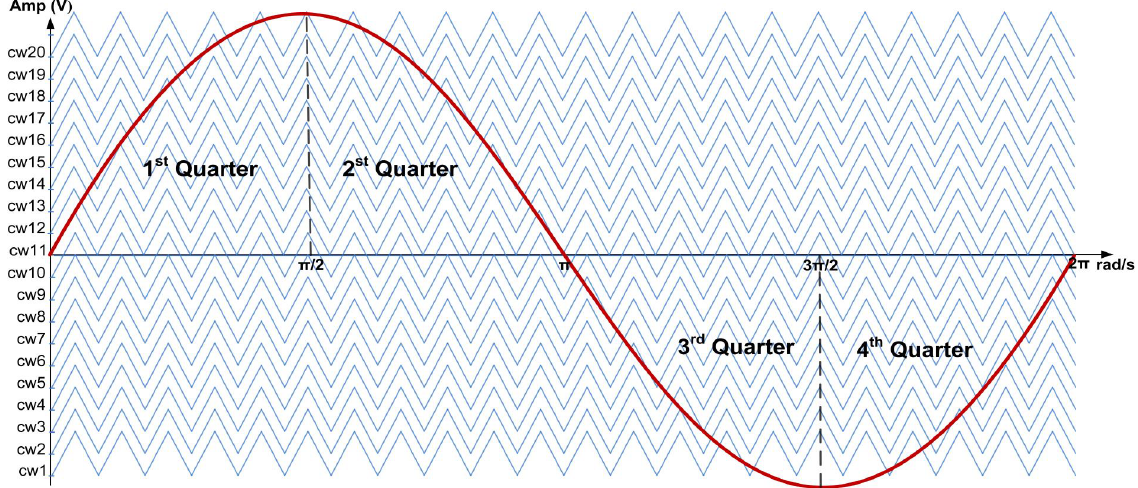
Figure 3. Symmetric disposition of multicarrier phase-disposition PWM (PD-PWM).